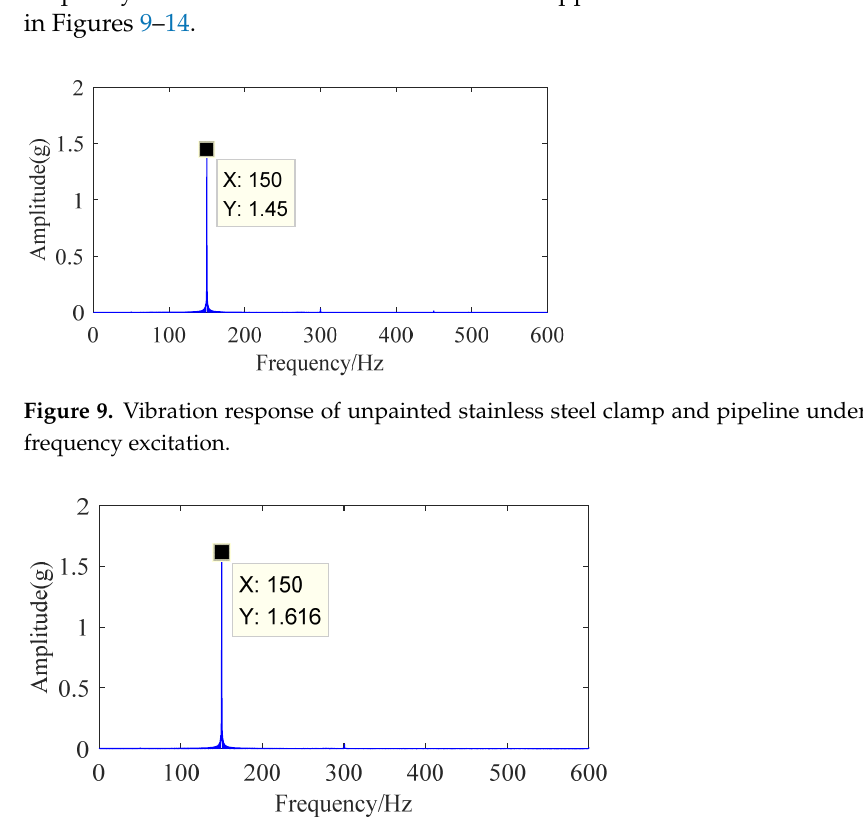
Figure 10. Vibration response of unpainted galvanized iron clamp and pipeline under 150 Hz fixed-frequency excitation.